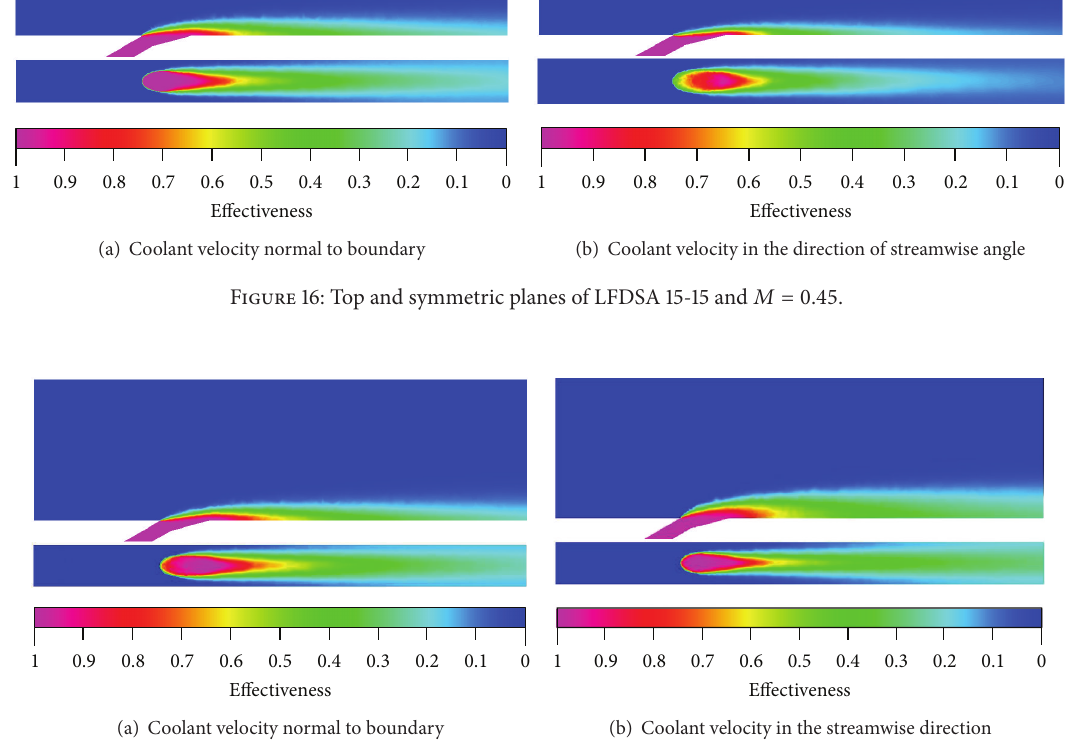
Figure 17: Top and symmetric planes of LFDSA 15-15 and 𝑀 = 1